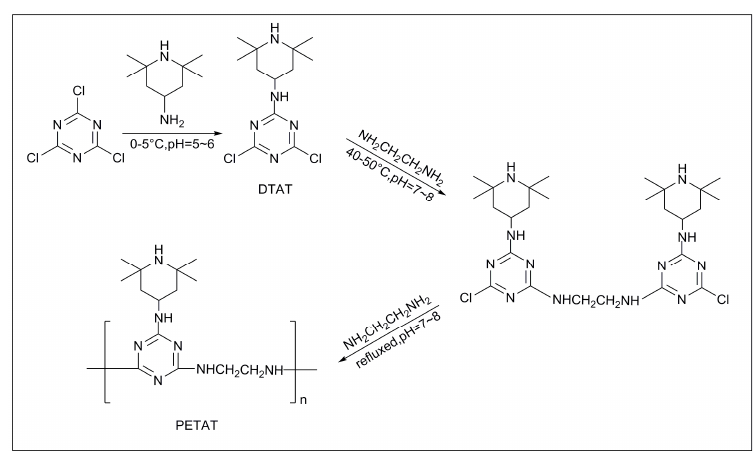
Figure 1. The synthesis route of TAT and PETAT (poly(ethanediamine-1,3,5-triazine-p-4-amino-2,2,6,6-tetramethylpiperidine)).